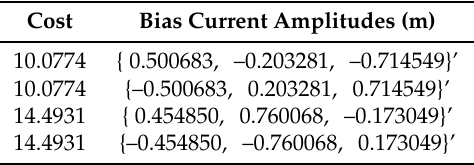
Table 1. Optimal bias results for 3–coils–failed